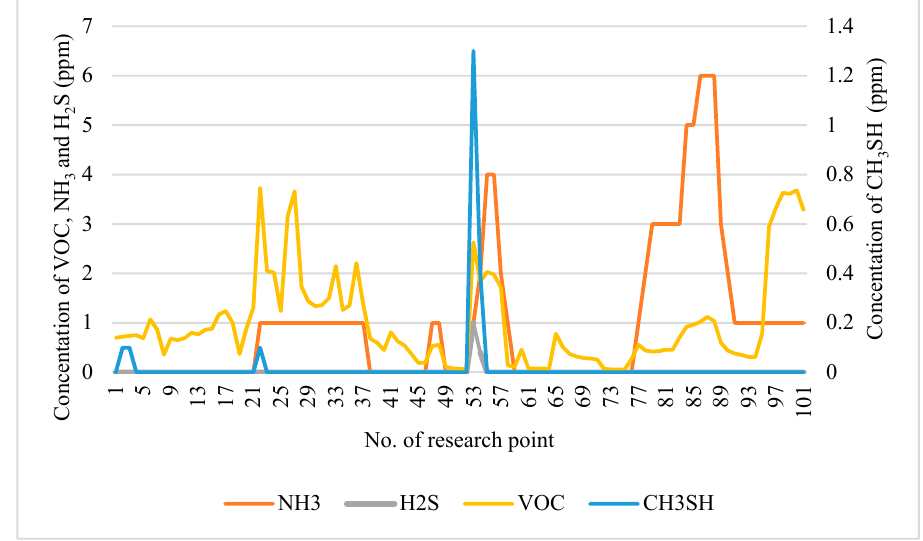
Figure 1. Diagram showing odorant measurement results in the biogas plant in Wólka Rokicka (own elaboration based on ProRae Studio